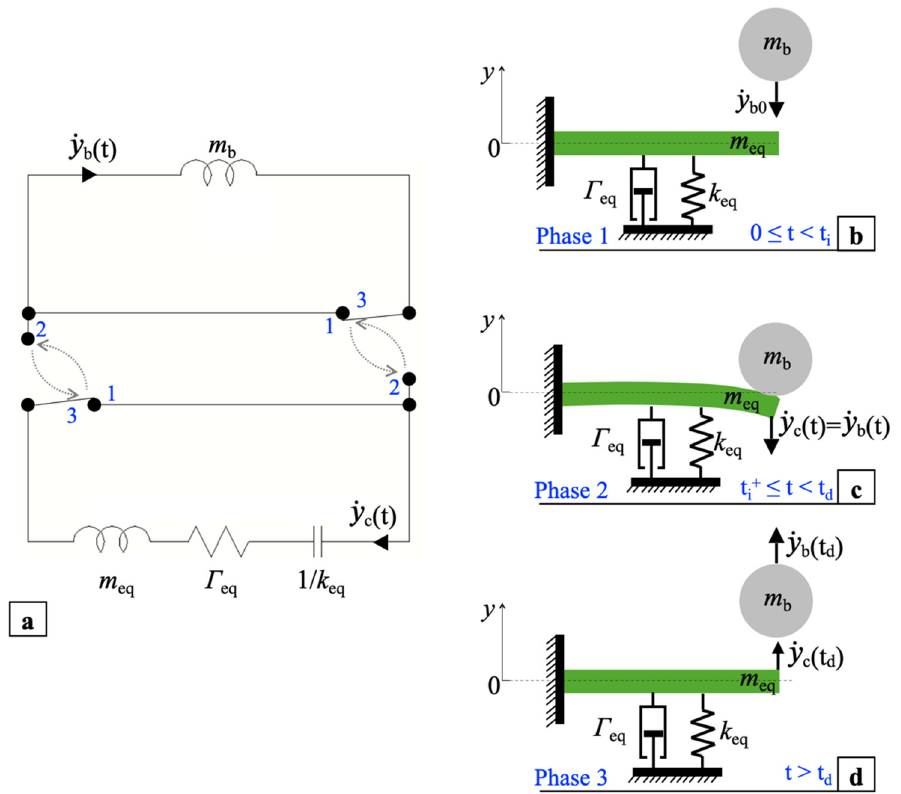
Figure 5. Lumped-element equivalent circuits ( a ) and equivalent simplified mechanical model of a single ball impact piezoelectric converter before the impact ( b ), after the impact ( c ), and after the detachment of the ball from the cantilever ( d ).